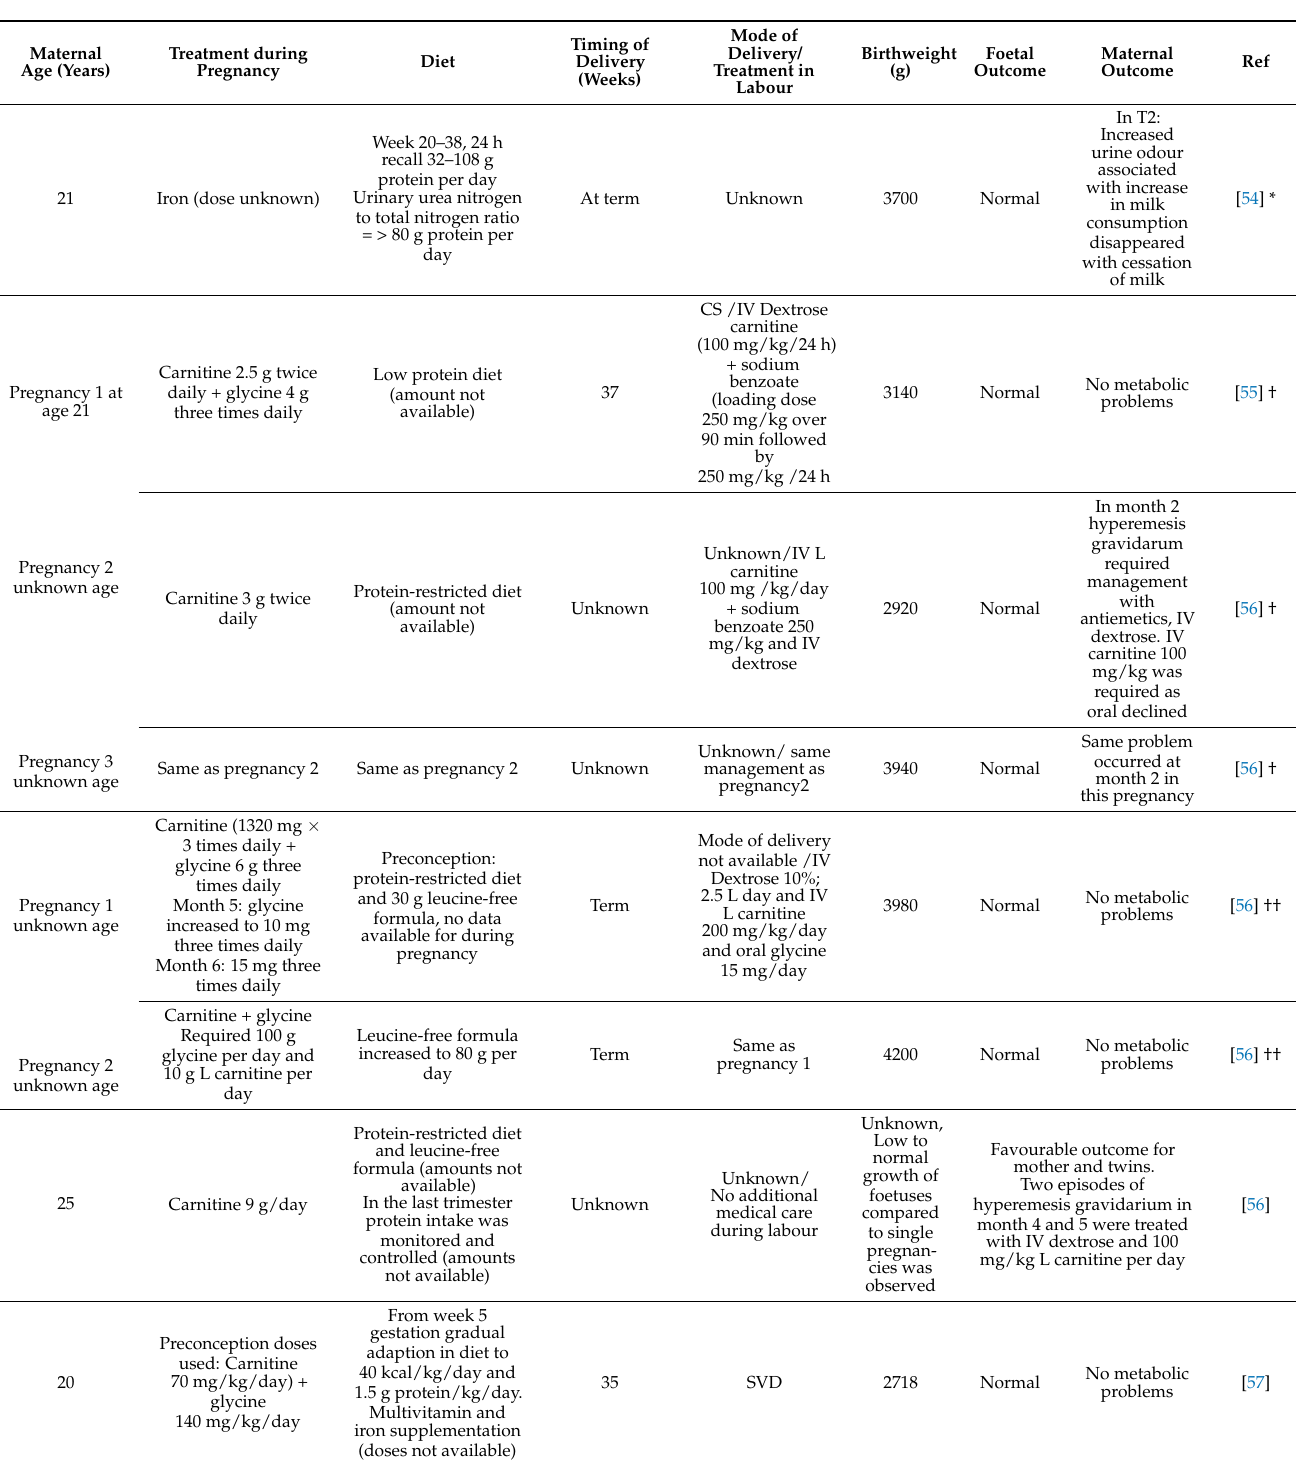
Table 5. Published literature on pregnancies in